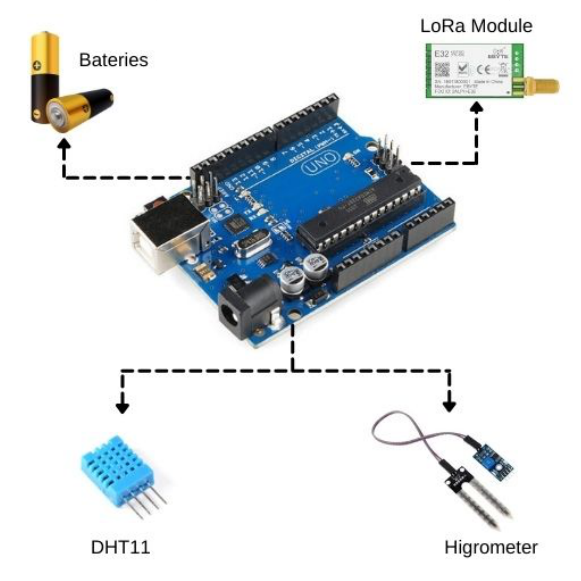
Figure 5. Sensor node